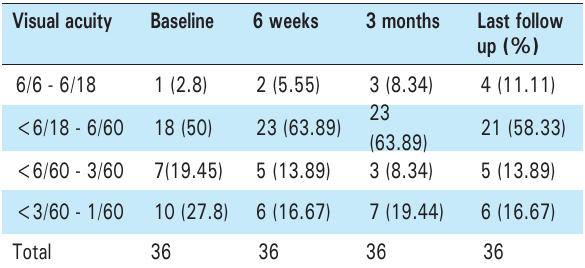
Table 6. Best corrected visual acuity before and after macular hole